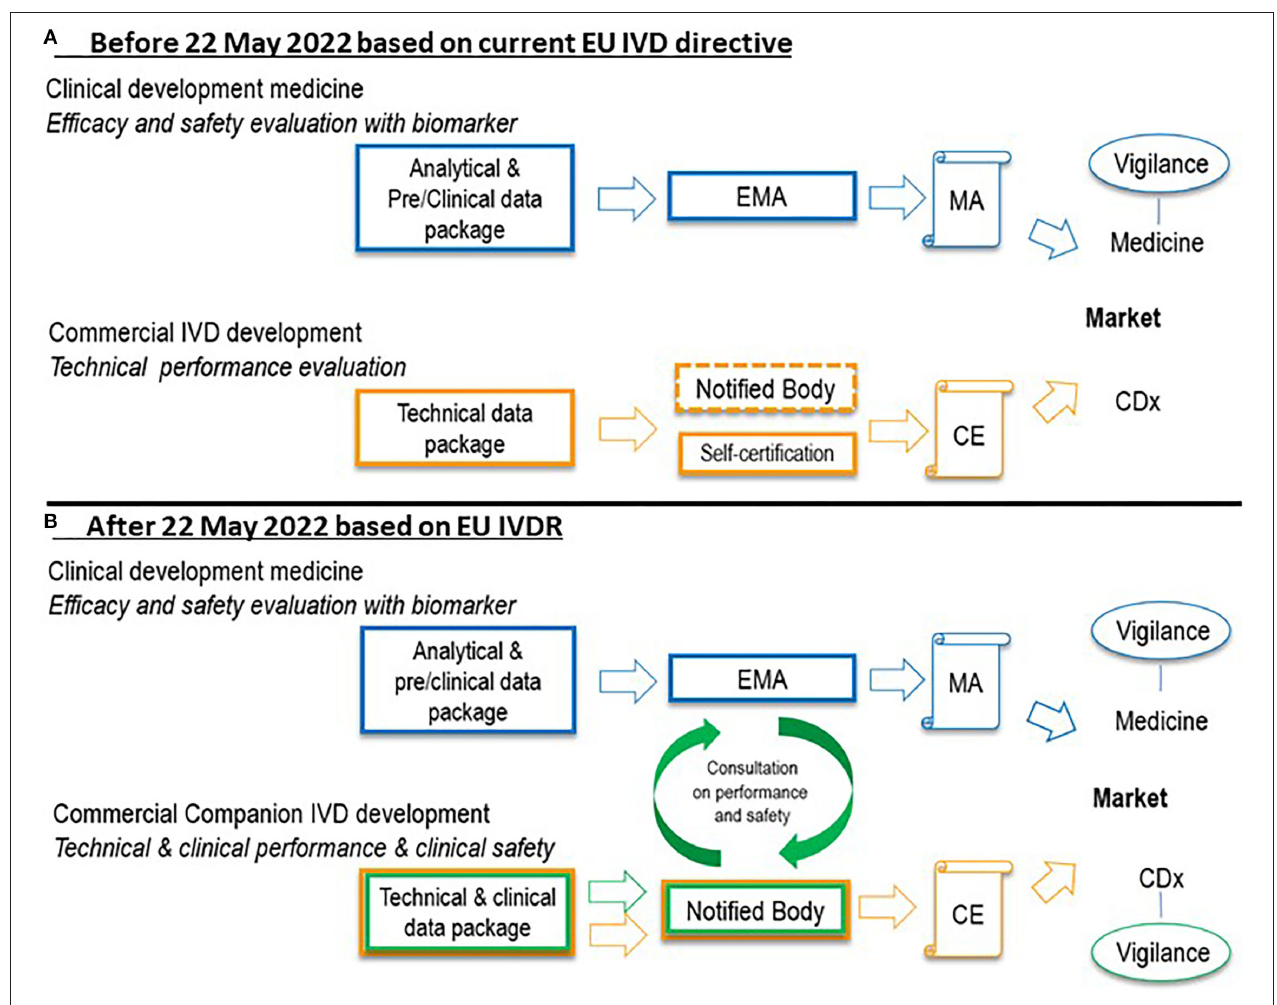
FIGURE 1 | Situation before 22 May 2022 (A) and after 22 May 2022 (B) with regard to certification of a new CDx in combination with a medicine in the European Union. In the current situation under the IVD directive, technical data in support of CDx are not assessed by notified bodies (self-certification), indicated by the dashed notified body box line in (A) . Under the IVDR after 22 May 2022, such data, as well as performance data, will be assessed by notified bodies before granting a CE mark. EMA or national agencies of EU member states will be consulted by the notified body on performance and safety of the CDx. Further, a vigilance system will